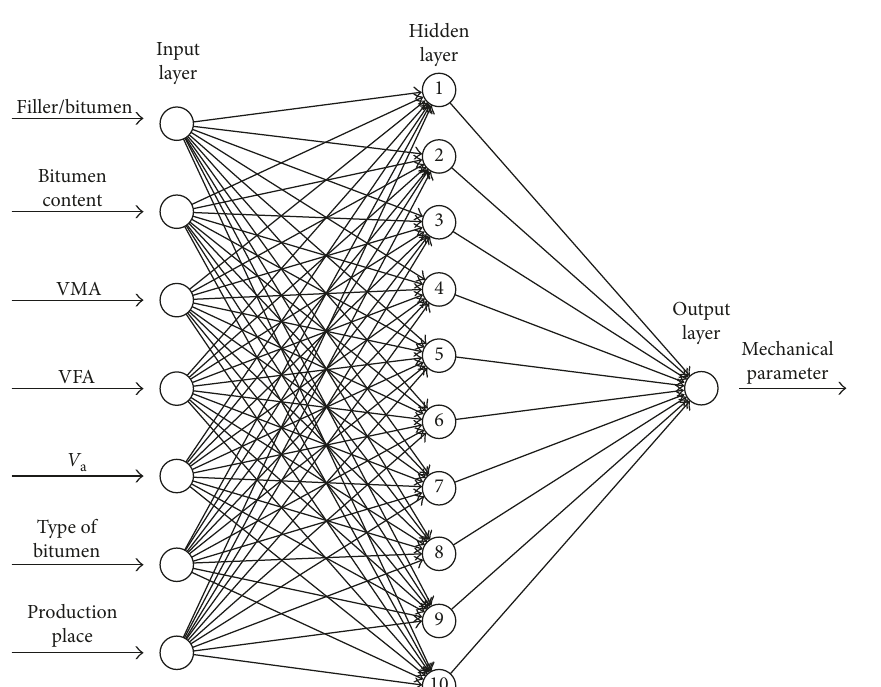
Figure 3: ANN structure adopted in the current